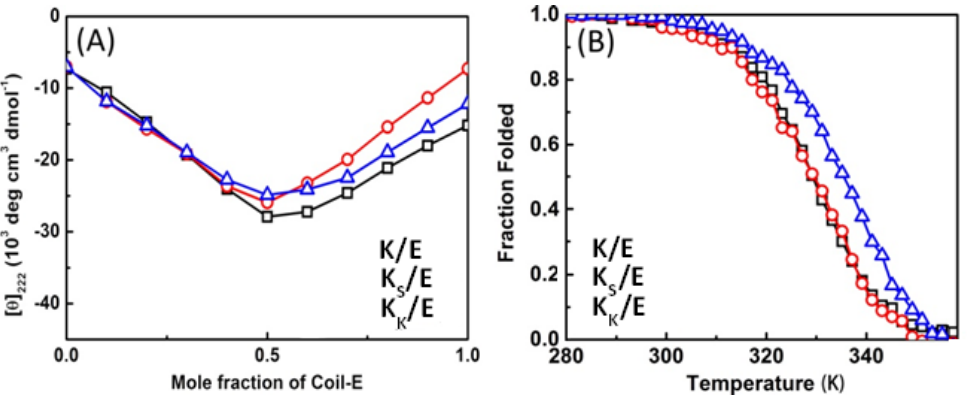
Figure 2: A) Mean residue molar ellipticities at 222 nm wavelength for mixtures of the K (or its derivatives) and E peptides as a function of the mol fraction of the E peptide. [Total peptide]=100 uM, 25 o C, 2 mm quartz cuvette. (B) Thermal unfolding curves of coiled coils in PBS buffer (pH=7.4) with increasing temperature from 6 o C (279 K) till 86 o C (359 K). A 1cm quartz cuvette with stirring bar at 900 rpm was used. [Total peptide] = 40 uM, PBS, pH=7.4.